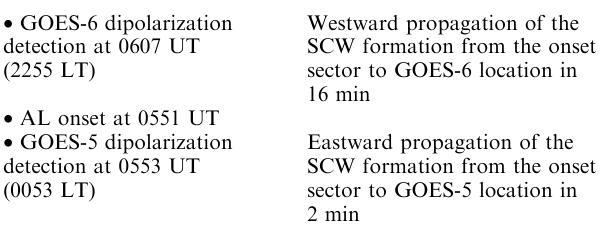
Table 4. The overview of the substorm that occurred on April 23, 1986, between 0500 and 0800 UT